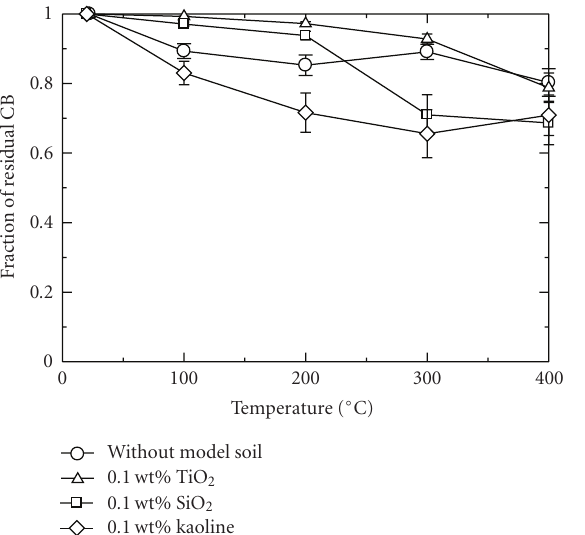
Figure 3: The fraction of residual chlorobenzene (CB) at di ff erent Figure 2: The fraction of residual chlorobenzene (CB) at di ff er- temperatures. Flow rate 1.0cm 3 min − 1 and P = 30MPa. CB = 1mM, ent temperatures. Fluidized-bed-type reactor with the flow rate [H 2 O 2 ] = 0.1 wt%. : without model soil; (cid:5) : 0.1wt% TiO 2 ; (cid:6) : 1.0 cm 3 min − 1 and P = 30 MPa. CB = 1mM. : without model soil; (cid:3) : 0.1 wt% SiO ♦ : 0.1wt% kaoline. (cid:2) : 0.1 wt% TiO 0.1 wt% SiO 2 ; (cid:7) : 0.1wt% 2 ; 2 ;